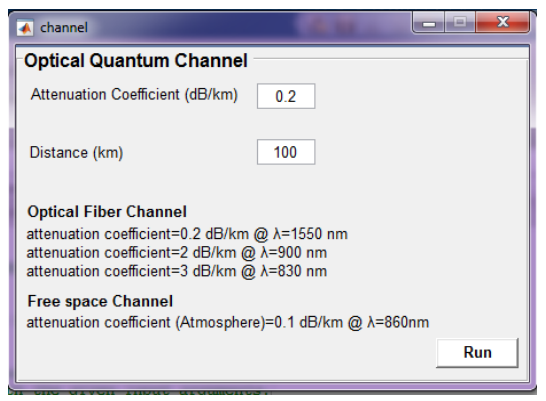
Fig. 5. OF quantum channel simulator window.